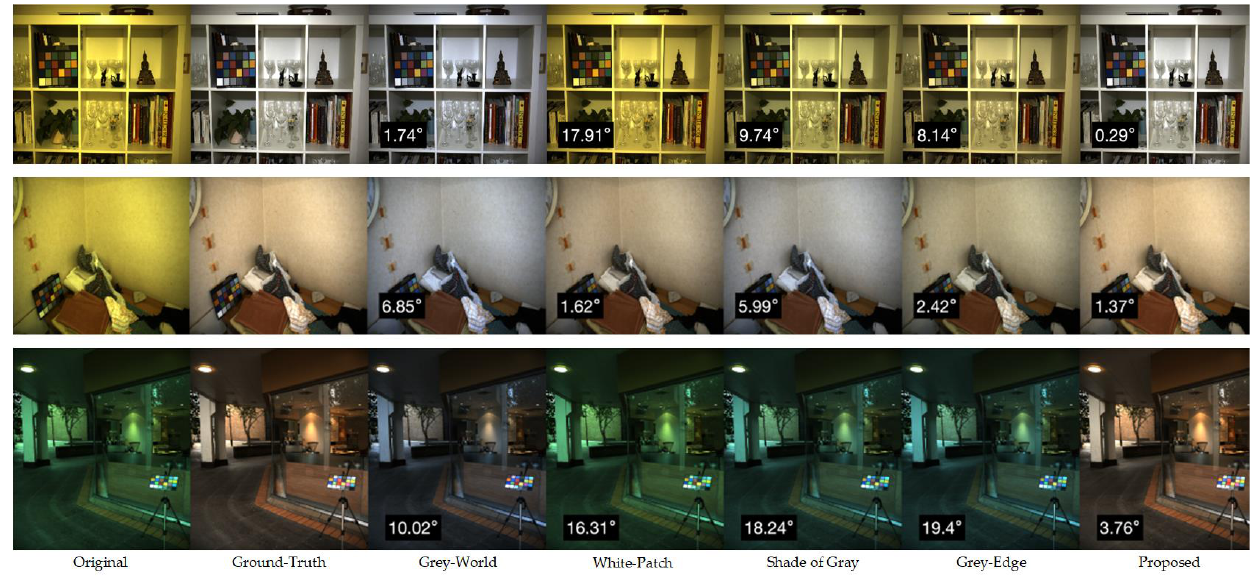
Figure 3. Color constancy results of Gray-World, White-Patch, Shades of Grey, Grey-Edge, and proposed on Gehler-Shi test dataset. The angular error is indicated in the left bottom corner. Table 4. Performance of different color constancy methods on the Gehler-Shi dataset.